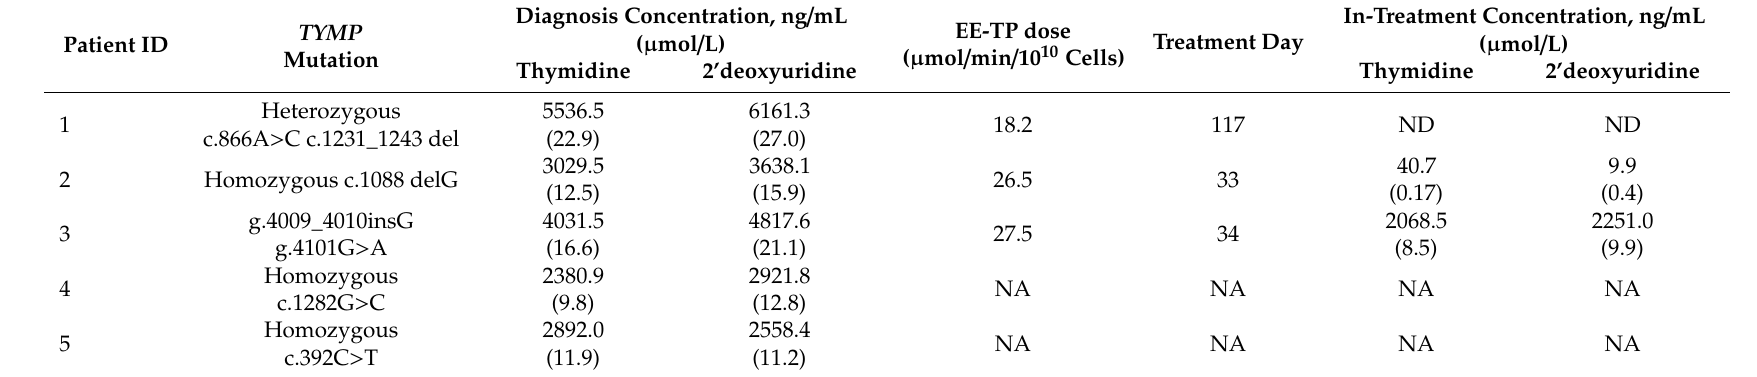
Table 5. Plasma thymidine and 2’deoxyuridine concentrations in patients with MNGIE prior to therapy and during therapy with EE-TP (patients 1 to 3) and in patients tested for MNGIE (patients 4 and